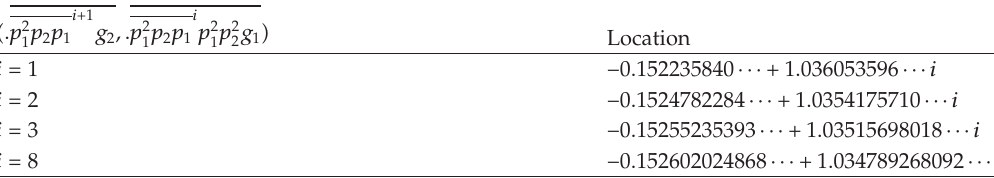
Table 5: Location of canonical quadruple-spiral medallions.